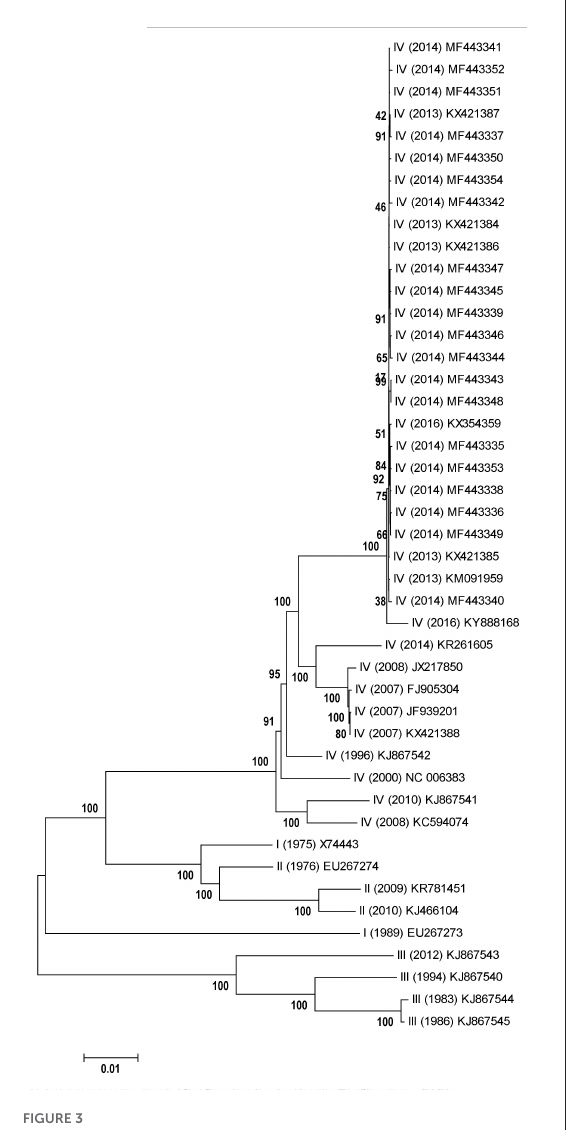
FIGURE3 Phylogenetic relationships of PPRV genome sequences. Representation is a neighbor-joining tree of 45 PPRV genome sequences generated in this work. The phylogenetic tree is unrooted. The scale bar is given in numbers of substitutions per site. Bootstrap resampling (1,000 replications) support values are represented at the